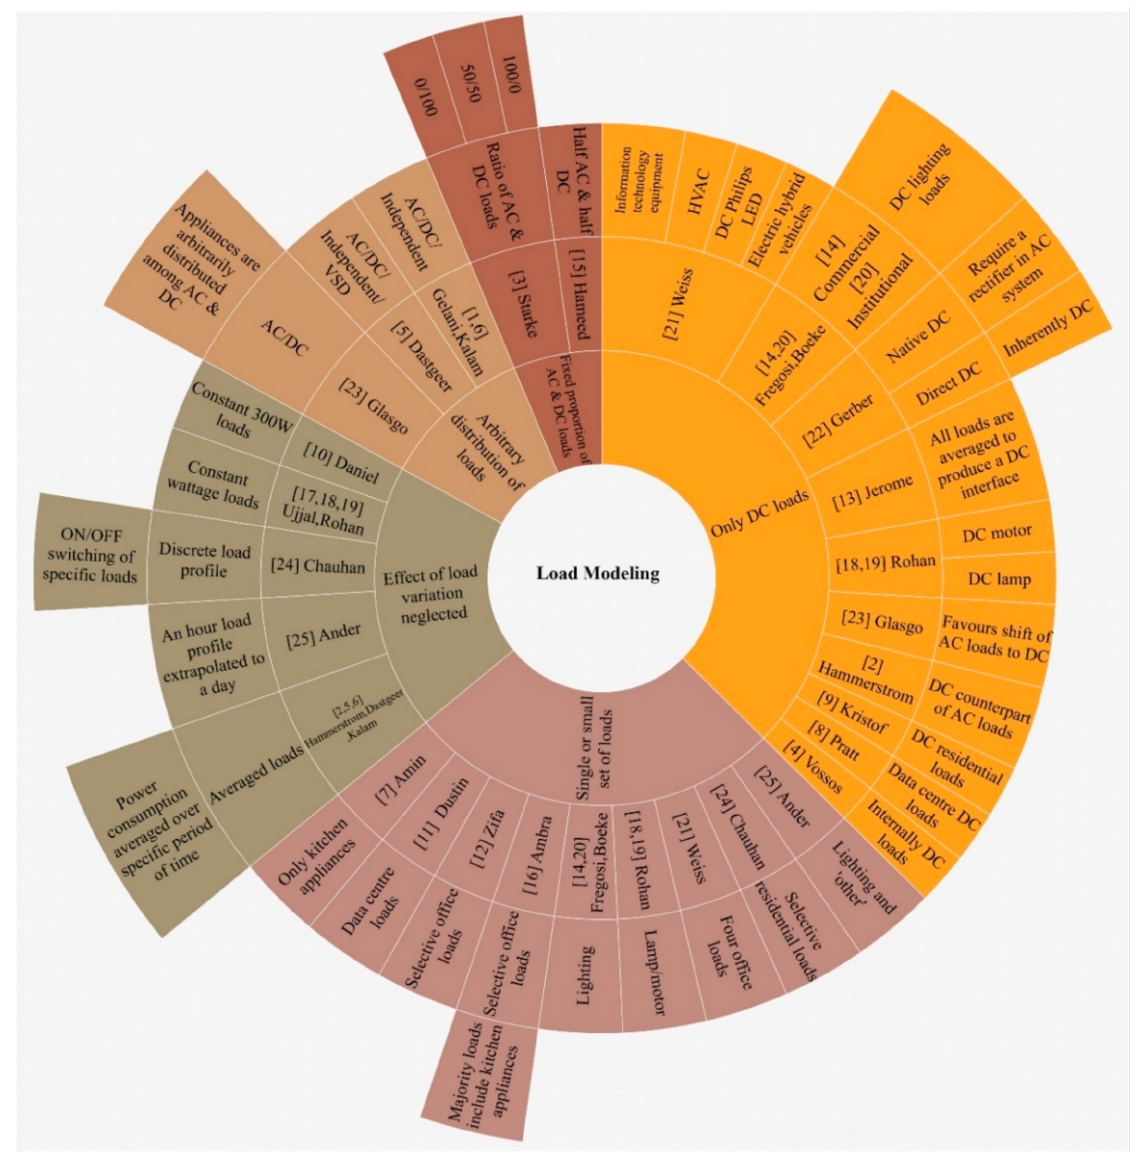
Figure 3. Load modeling presented in various studies